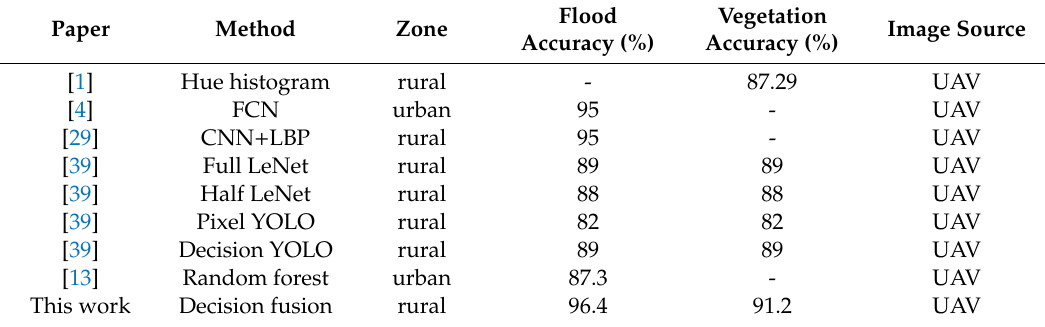
Table 7. Accuracy comparison with other